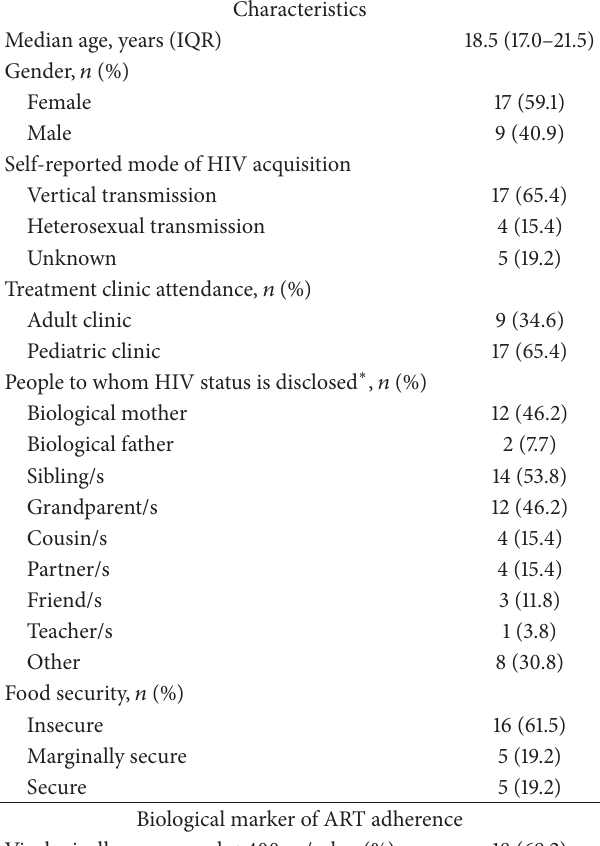
Table 1: Characteristics of adolescents and young adults who participated in FGDs and IDIs ( 𝑛 = 26